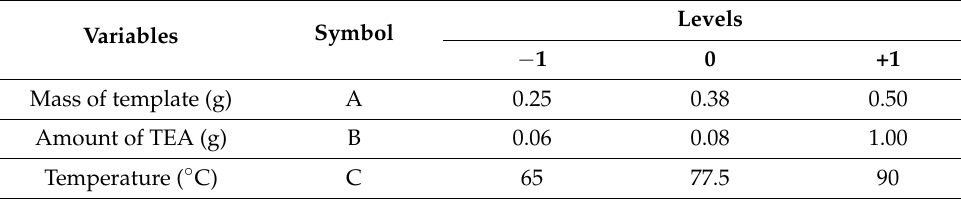
Table 1. Uncoded and coded levels of